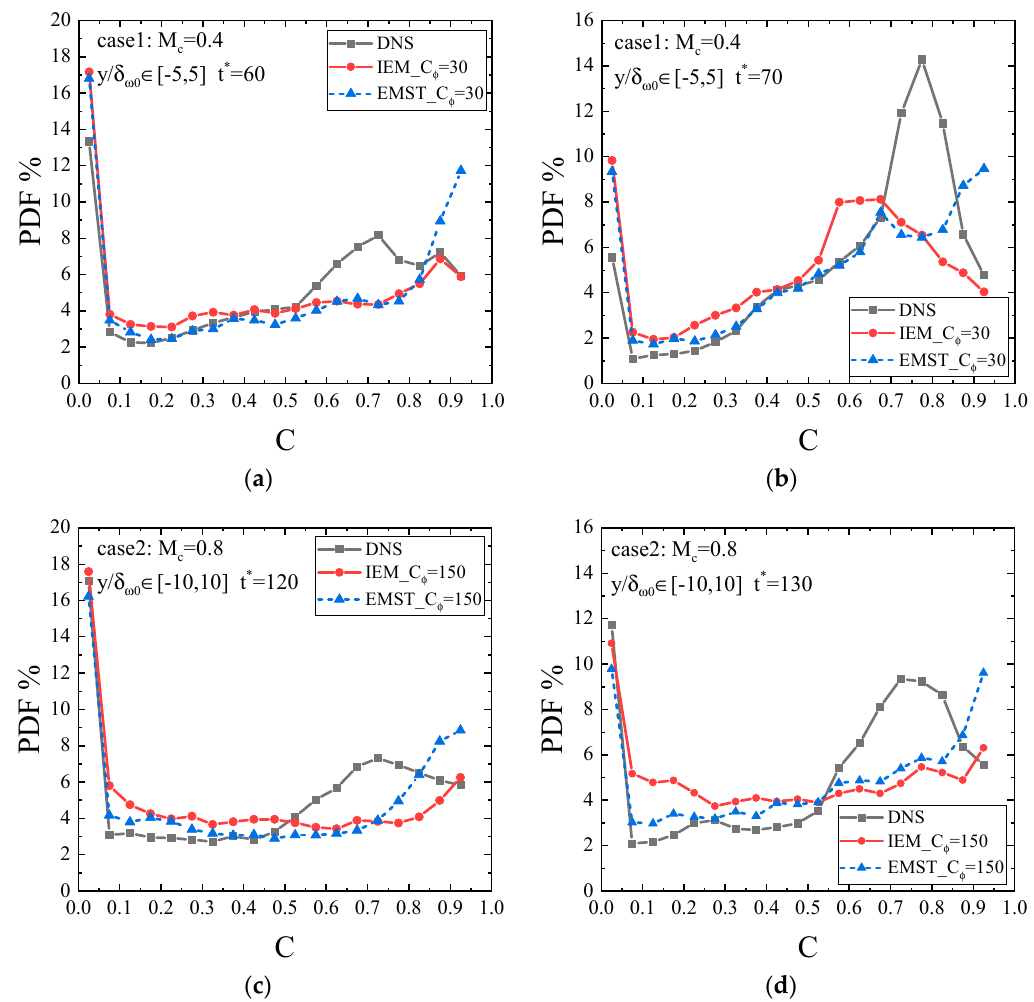
Figure 15. Probability density function of the progress variable at four moments: ( a ) t ∗ =60 in M c = 0.4 case, ( b ) t ∗ =70 in